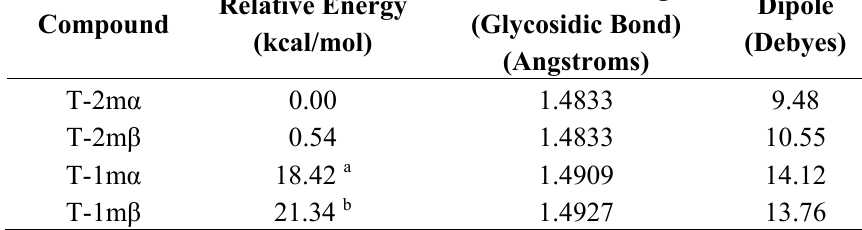
Figure 4. Results of M06-2X/QZVP//M06-2X/6-31 + G(d,p) calculation on model forms of tautomers 1 and 2